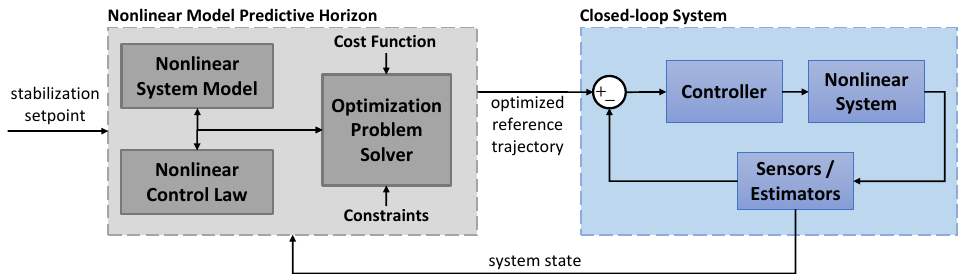
Figure 2. NMPH architecture. A model of the nonlinear system dynamics is used to perform the optimization process within NMPH (gray box). The resulting optimized reference trajectory is passed to the actual closed-loop system (blue box) for tracking